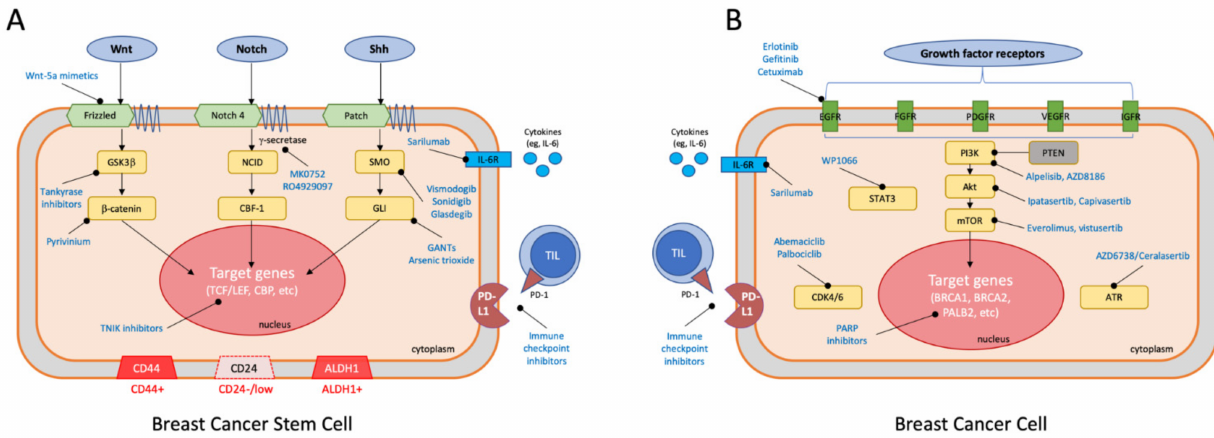
Figure 1. Summary of CSC specific mechanisms and pathways targeting breast cancer stem cells ( A ) and non-CSC specific mechanisms and pathways targeting breast cancer cells ( B